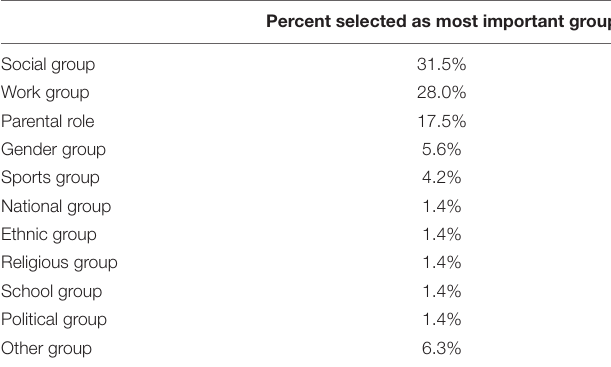
TABLE 2 | Percentages of group importance in Study 2.